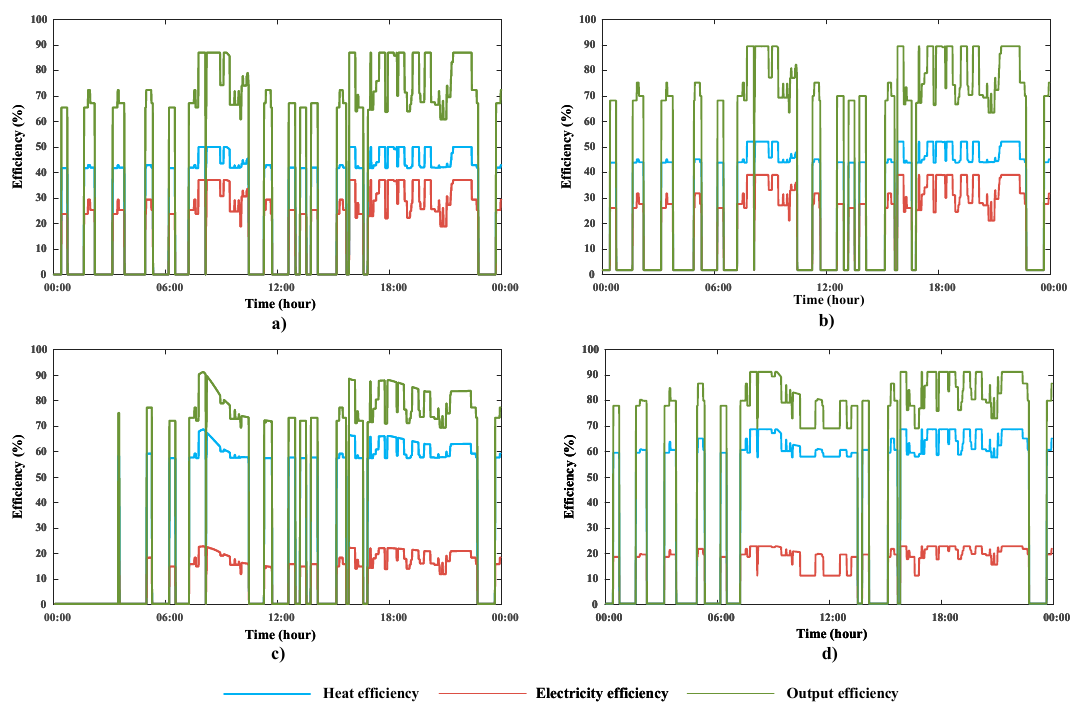
Figure 9. CHP output efficiencies in each minute of a spring day based on different sizing criteria. ( a ) Spring, fuel cell CHP, heat dependant sizing CHP; ( b ) Spring, fuel cell CHP, electricity dependant sizing CHP; ( c ) Spring, gas engine CHP, heat dependant sizing CHP; ( d ) Spring, gas engine CHP, electricity dependant sizing CHP.